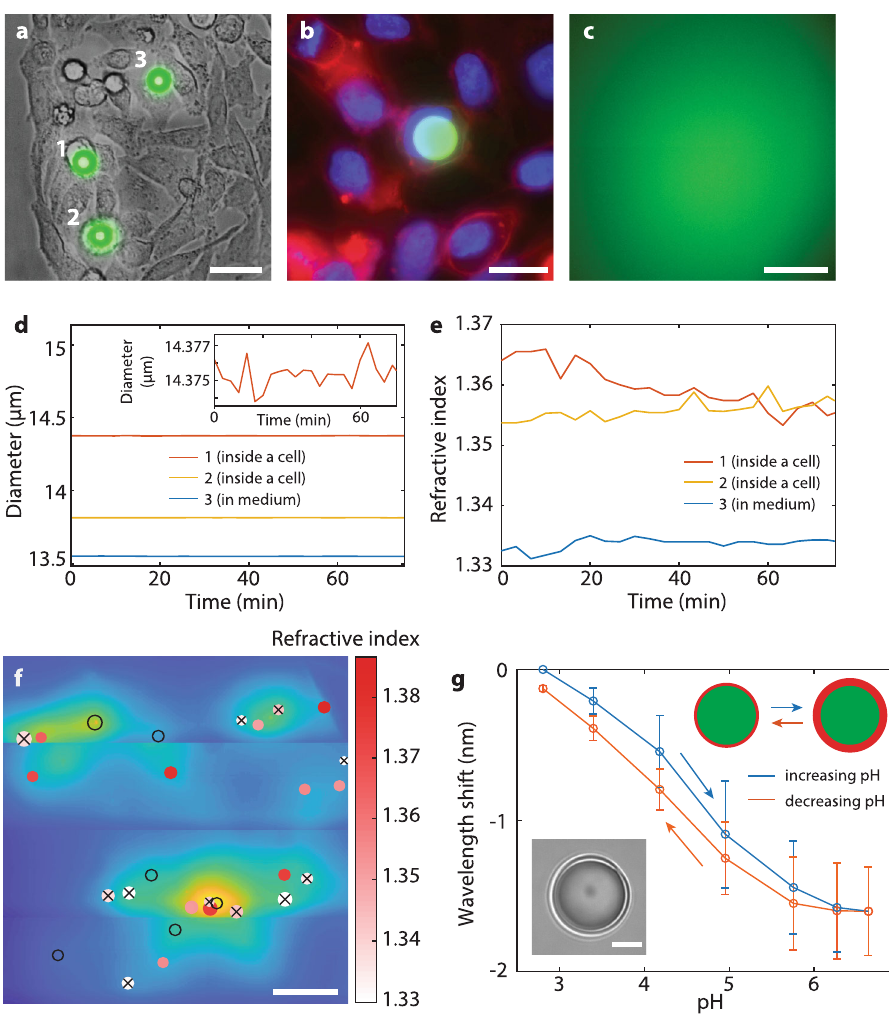
Fig. 3 Simultaneous sensing and imaging. a Combined bright- fi eld and fl uorescence image of three microcavities, two of which are inside the cells (1 and 2). Scale bar, 30 μ m. b Fluorescence image of a number of cells, one of them containing an internalized microcavity (green). The cell nuclei and cell membranes are stained in blue and red, respectively. Scale bar, 20 μ m. c Fluorescence image of the area in a through a phantom (1.5 l * ). Scale bar, 100 μ m. d The assessed diameters of three microcavities over time. (Inset) The assessed diameter of microcavity 1. e The assessed refractive indices in the surroundings of the same three microcavities over time. f Positions, sizes (proportional to the circle size) and surrounding refractive indices of a number of microcavities in a cell culture obtained with DSLI through a phantom (1.0 l * ). For the microcavities denoted by black empty circles, only their size was determined. Microcavities denoted by a black cross were identi fi ed as being outside the cells. The background image represents the fl uorescent intensity distribution at the phantom surface. Scale bar, 500 μ m. g Shift of the spectral peaks of microcavities coated with a pH-sensitive hydrogel was measured through a phantom (1.0 l * ) as the pH was changing. The plot represents the average response from 5 different microcavities, where the error bars represent the standard deviation. (Inset) Bright- fi eld image of a coated microcavity. Scale bar, 5 μ